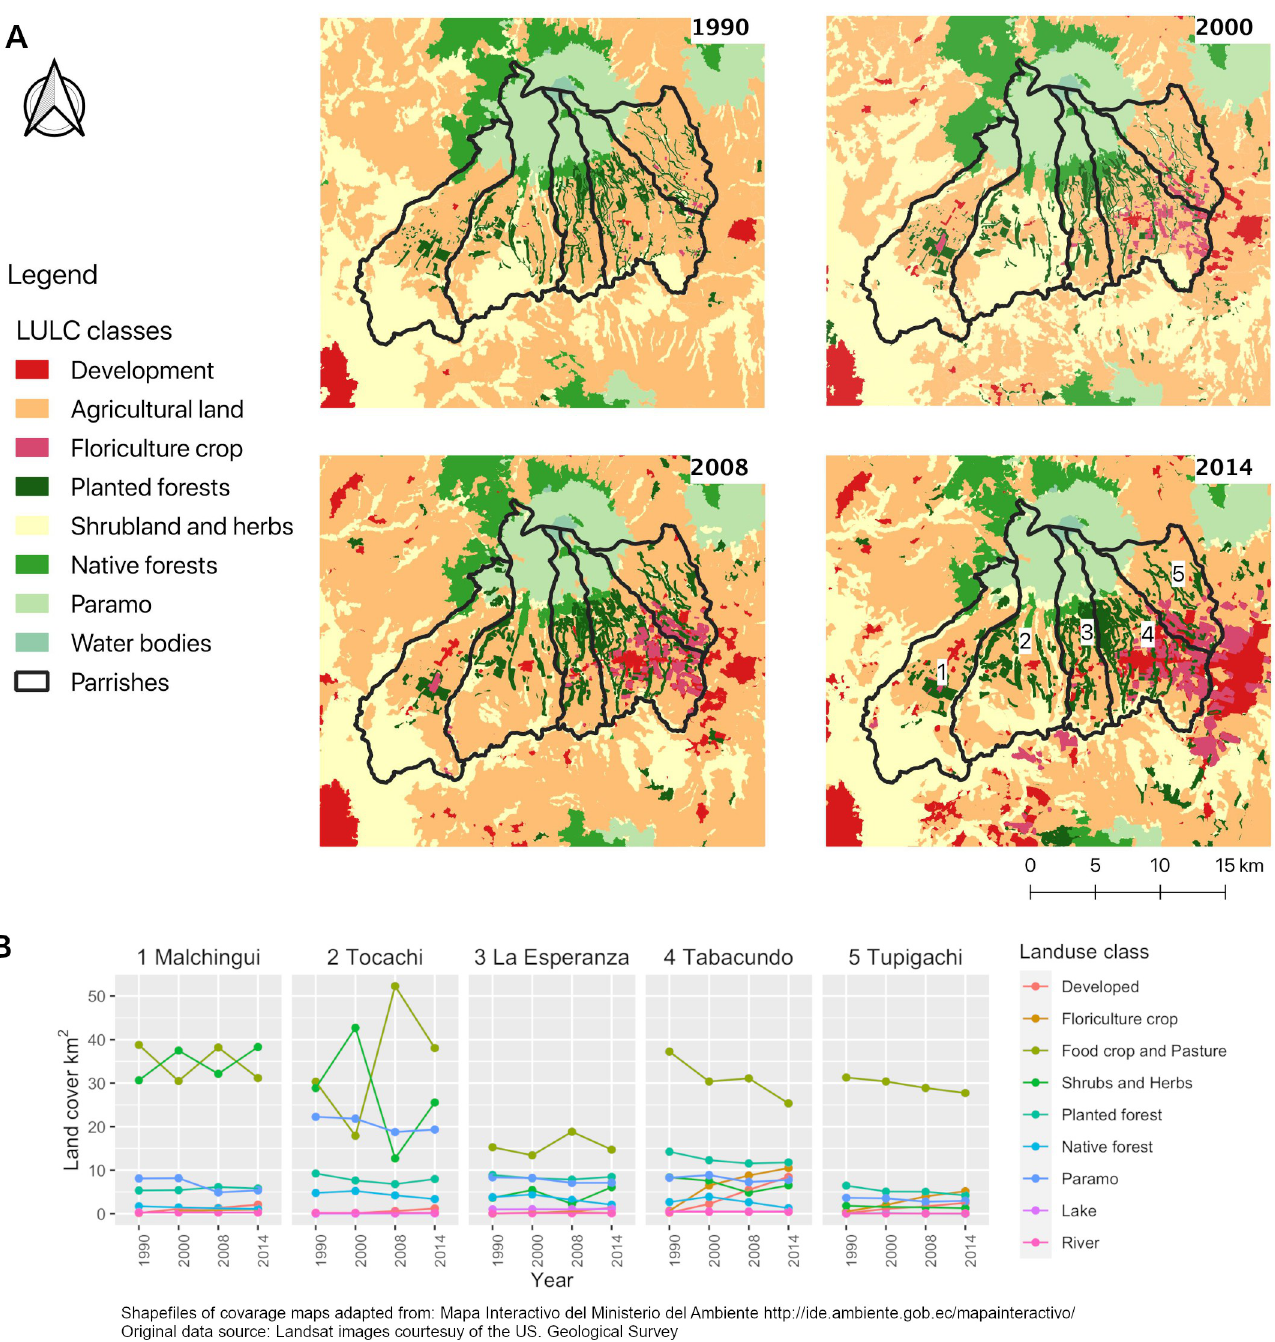
Fig 3. Land use land cover changes in Pedro Moncayo county through time. A. LULC maps throughout the periods of study (1990, 2000, 2008 and 2014). B. Land extent changes through time in Pedro Moncayo county by administrative zones (parishes).